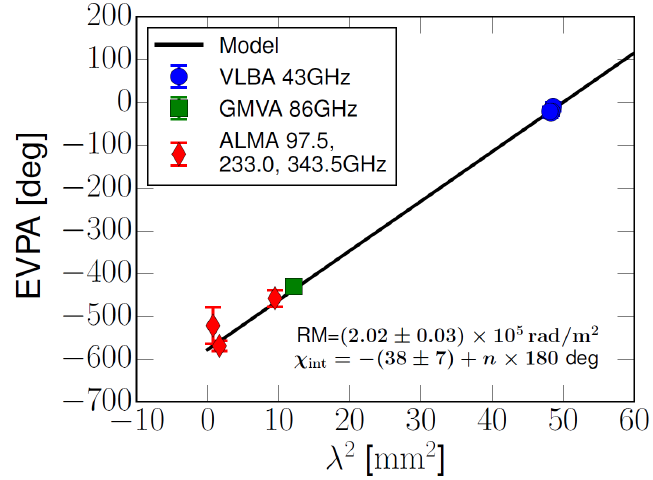
Figure 7. EVPAs of 3C 84 as functions of λ 2 from contemporaneous VLBA 43 GHz (blue), GMVA 86 GHz (green), and ALMA 97.5, 233.0, and 343.5 GHz data (red). The black solid line is a linear fit to the data points, from which the best-fit RM = ( 2.02 ± 0.03 ) × 10 5 rad m − 2 and χ int = − ( 38 ± 7 ) ◦ are derived